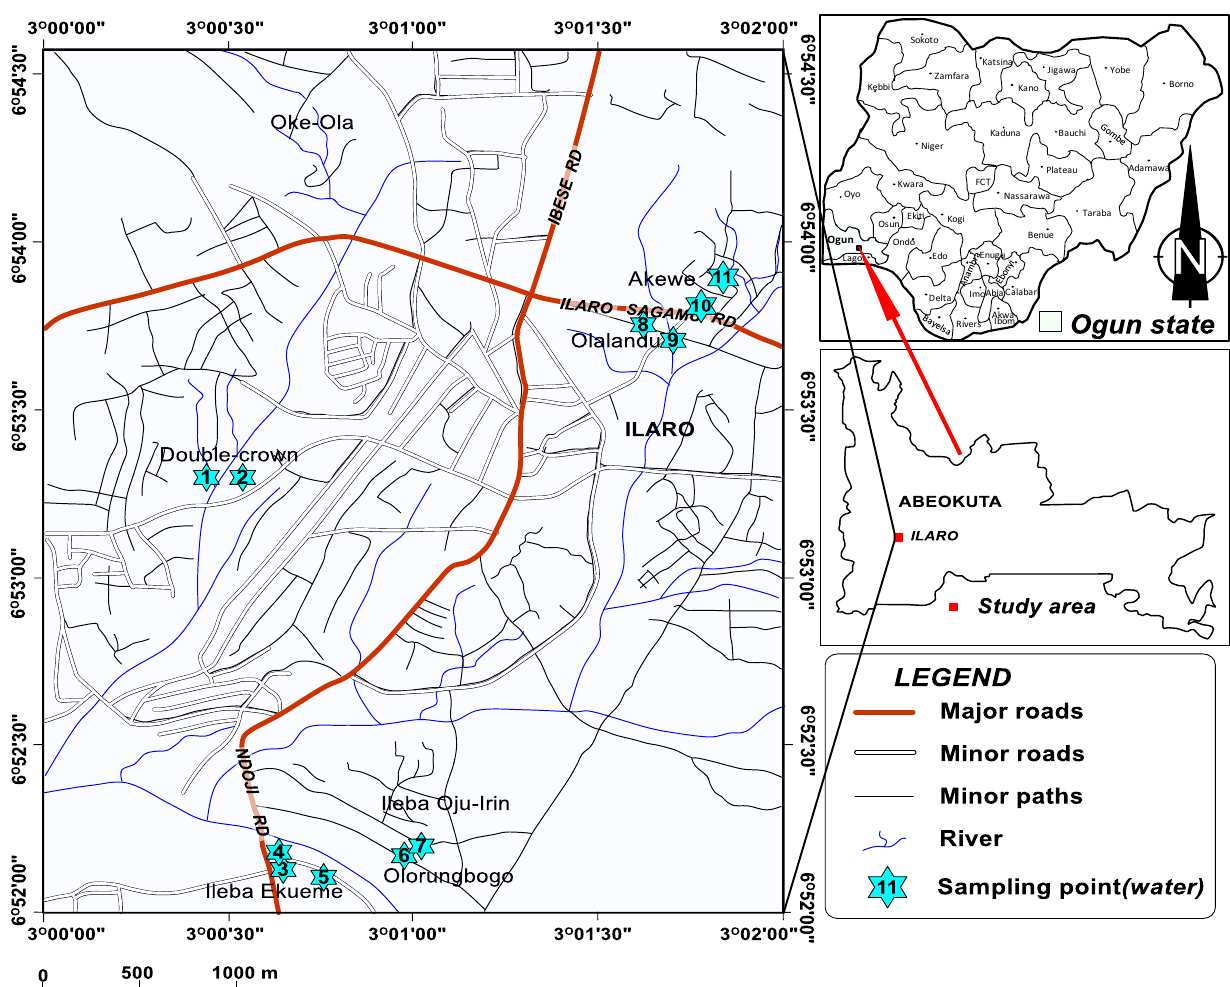
Fig. 2 The Location Map Showing the Study Areas and Sampling